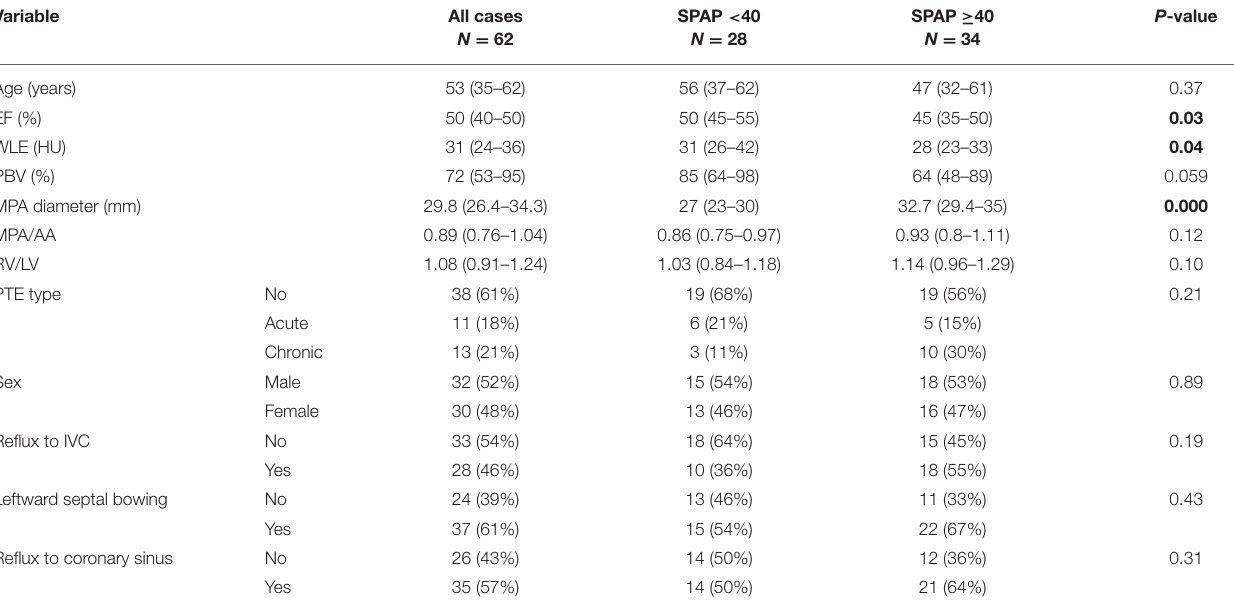
TABLE 3 | Comparison of baseline and CT parameters according to SPAP of more or < 40mm Hg.